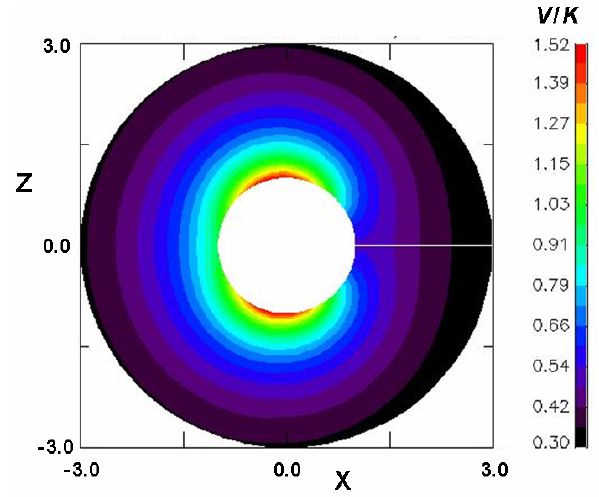
Fig. 9. Normalized potentials for the case R =0.5, α =1.2, φ b =9.3,